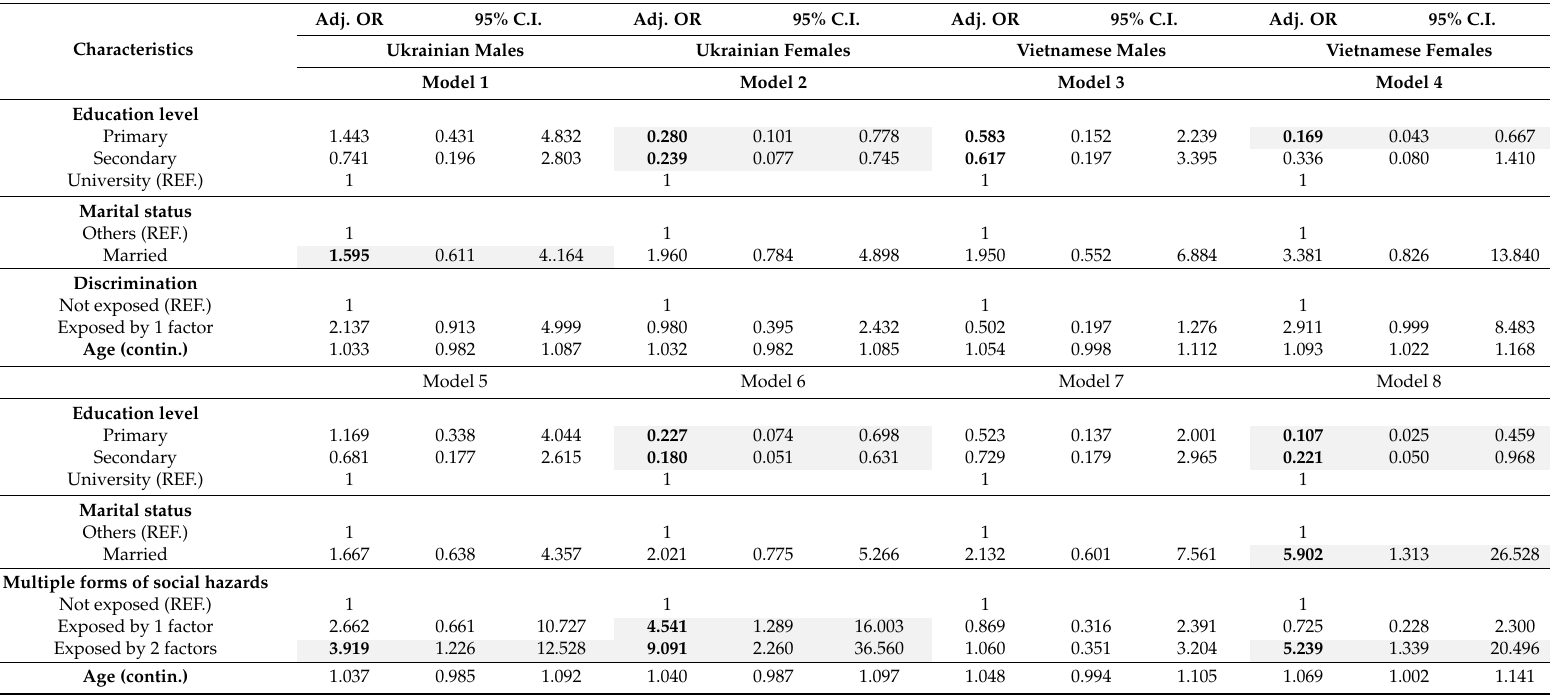
Table 2. The association of SRH, workplace loads and demographic variables, Ukrainians, Vietnamese, males and females (Dependent variable: 1 = Not good SRH; 0 = Good SRH; Adj. odds ratio OR and 95 % CI, 4 log. models).